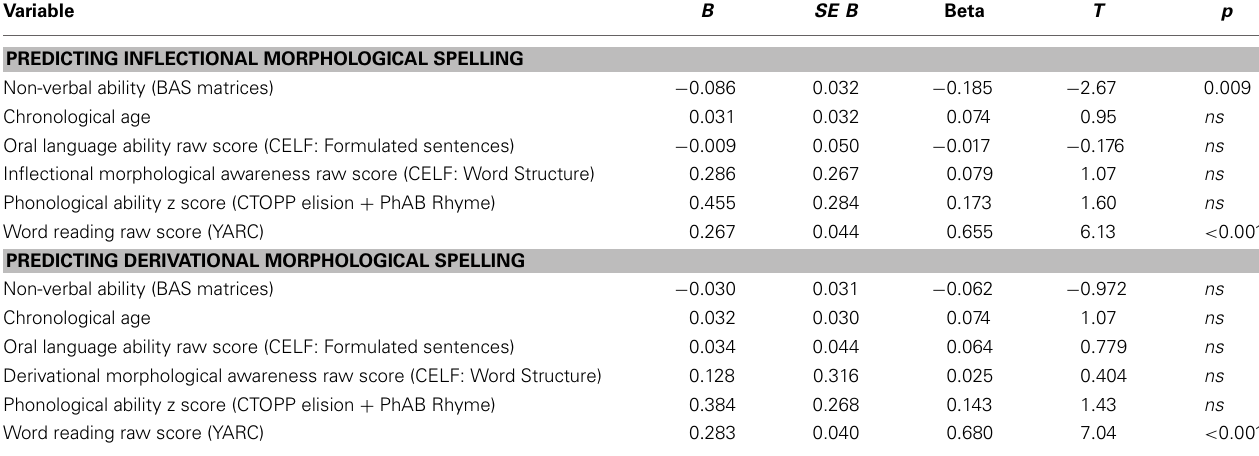
Table 5 | Summary of the final model of hierarchical regressions analysis when predicting inflectional and derivational morphological spelling